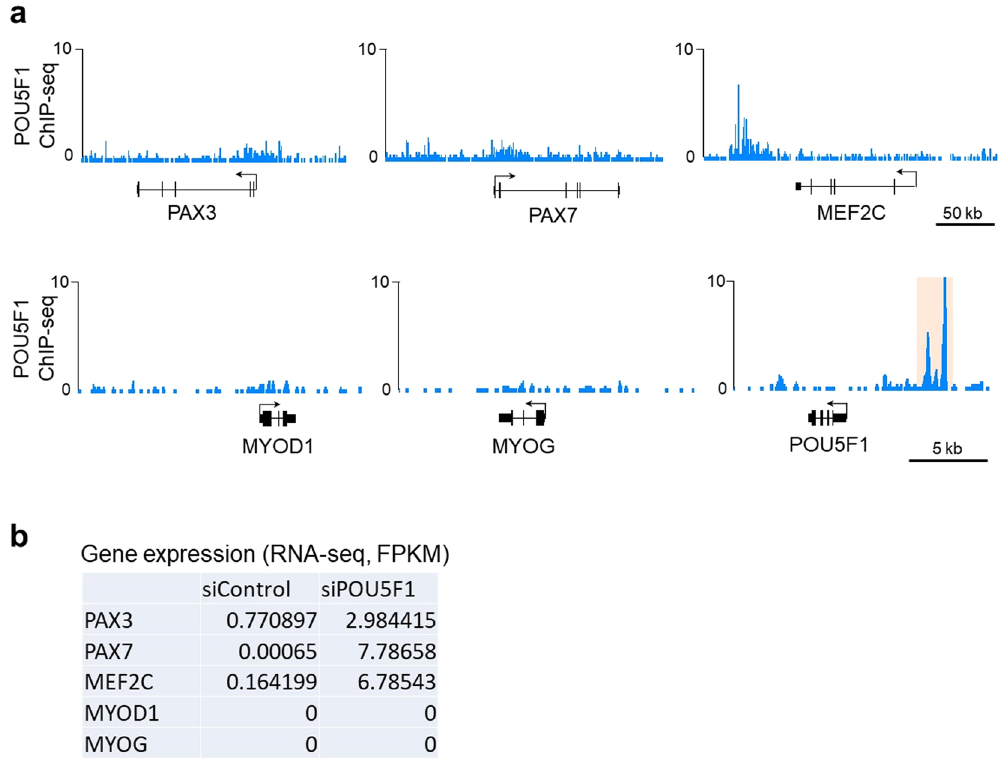
Figure 4. POU5F1 binding profiles around the myogenic gene loci and the effect of POU5F1 knockdown on the expression of the genes. ( a ) ChIP-sequencing tracks of POU5F1 for the loci of myogenic genes: PAX3, PAX7, MEF2C, MYOD1, and MYOG. The POU5F1 locus is shown as a positive control for the POU5F1 binding sites (orange). The data was obtained from a previous study 24 ( b ) Expression levels of myogenic genes in